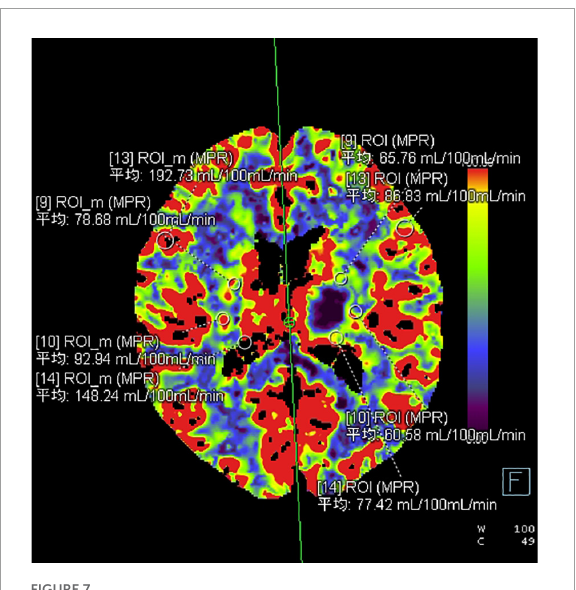
FIGURE7 The ROI and CBF values of the hematoma marginal area, cortical area, and corresponding mirror area.